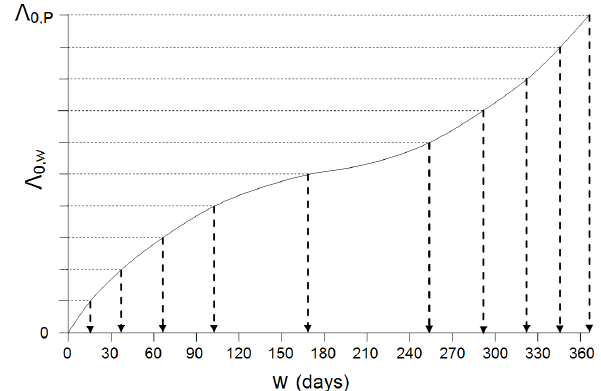
Fig. 2. Subdivision of the period P into n s subperiods (in this ex- ample n s = 10).